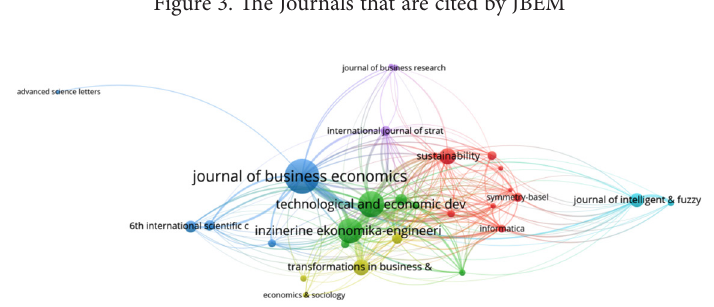
Figure 4. The map of citing publication of the